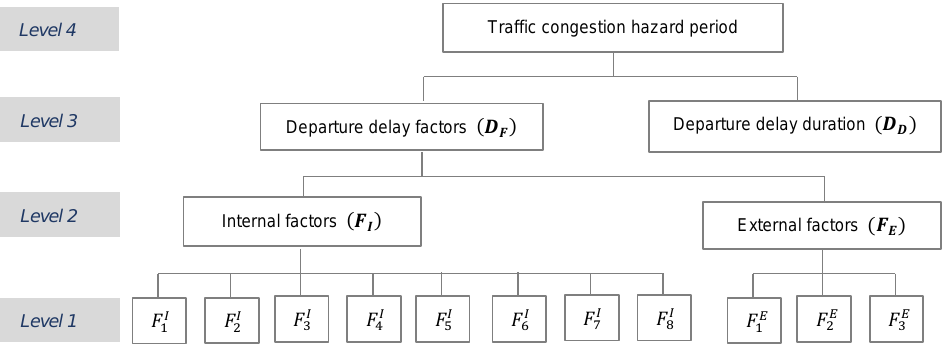
Figure 2. Hierarchical-based Fuzzy Synthetic Evaluation approach for assessing traffic congestion period. Details of internal and external factors shown at level 1 are given in Table 1.